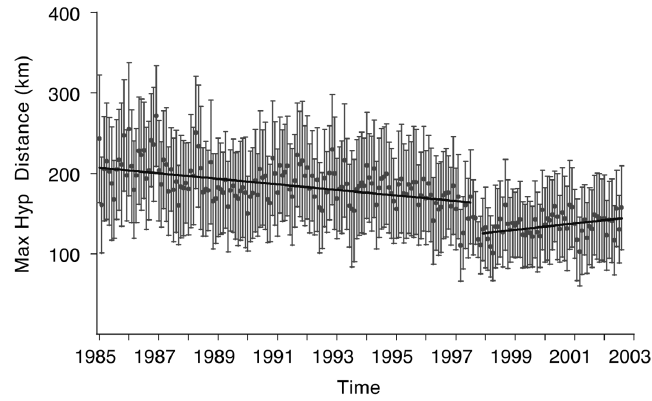
Fig. 4. Monthly averages (dots) of maximum hypocentral distance and associated standard deviation (bars) from year 1985 to August 2002. Only events with maximum distance less than 600 km contributed to the aver- age. The line represents the linear fit of the maximum distance versus